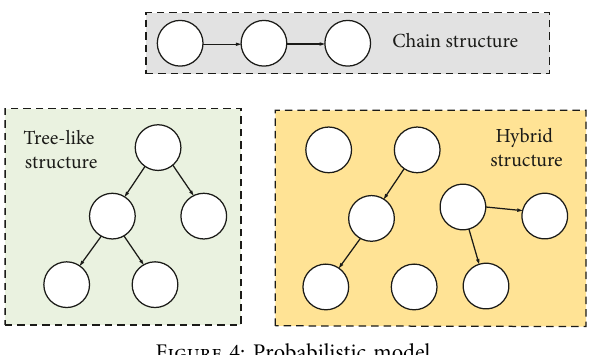
Figure 4: Probabilistic